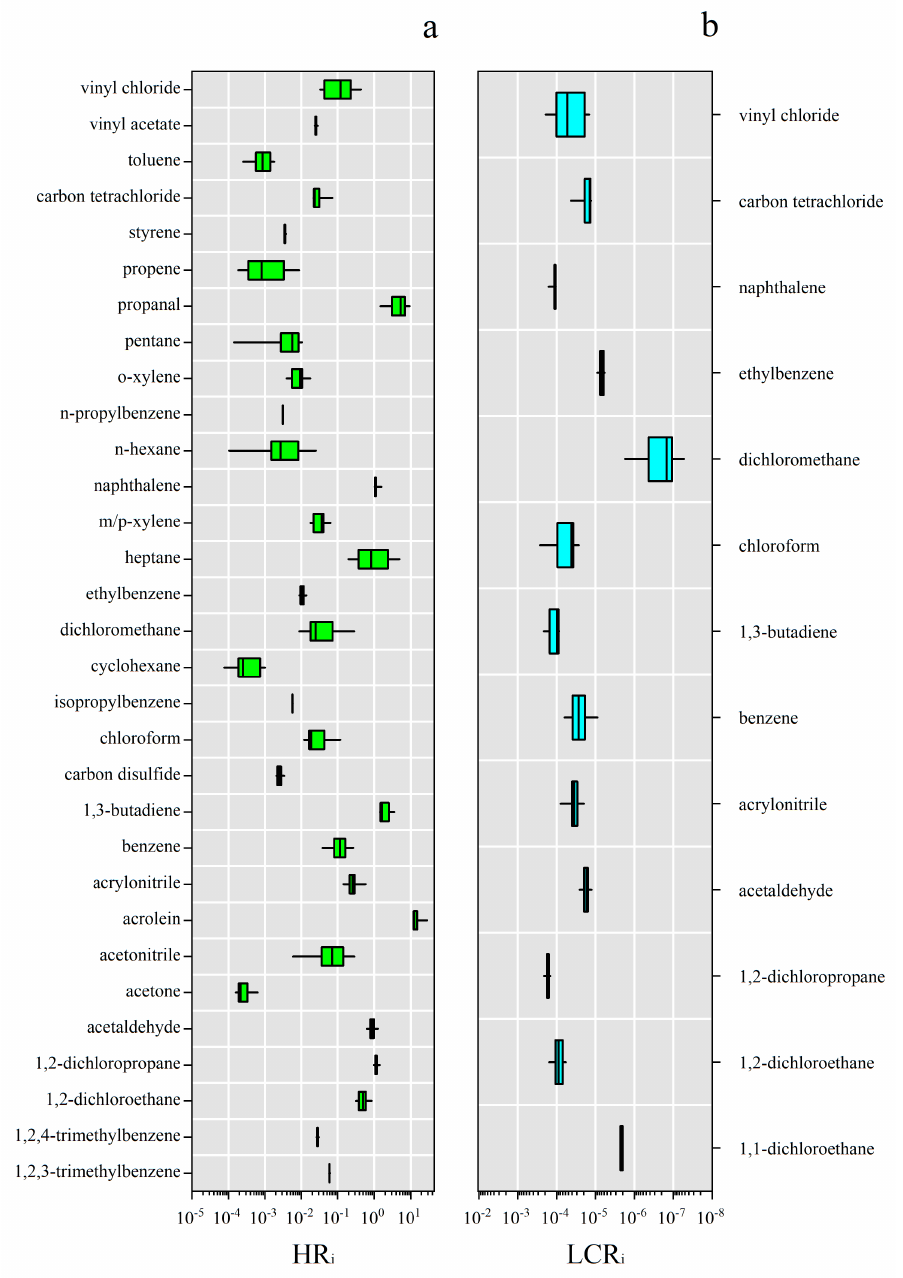
Figure 7. Distributions of non-cancer ( a ) and cancer ( b ) risks for individual VOC species. The box plots were constructed according to the 25–75th percentiles and the vertical lines inside the boxes represented the median values.